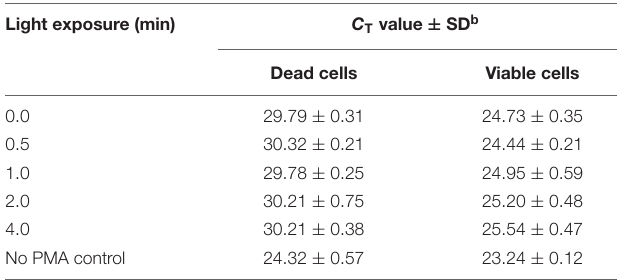
TABLE 2 | Light exposure influence on PMA treatment of signal suppression of dead cells of E. coli O157:H7 in PMA-qPCR a . Light exposure